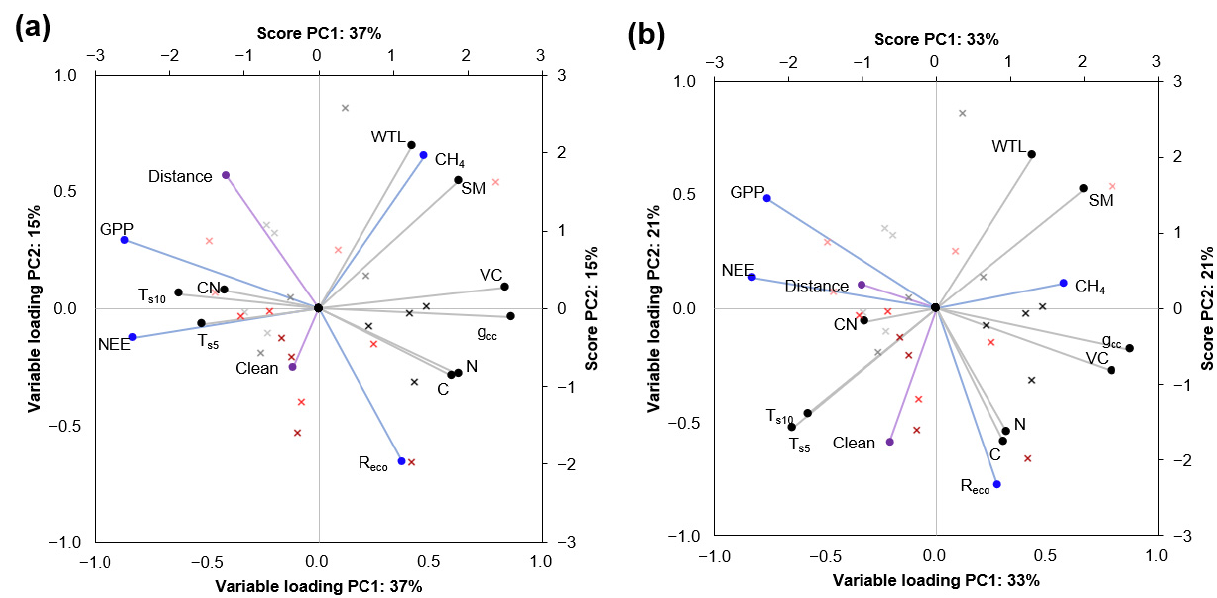
Figure 7. Principal component analysis (PCA) biplots of the first two principal components (PC1 and PC2) based on the plot-averaged measurement data displaying variable loadings and object scores, during ( a ) pre-DC and ( b ) post-DC periods. Variable loadings of all other significant PCs are listed in Table S3. Filled symbols denote the component loadings of the measured variables. Crosses highlighted in black (control area) and red (DC area) denote the component scores of each measurement plot. Colour intensity of component scores decreases with the distance to the ditches. Note that ecosystem uptake in NEE and GPP is given a negative sign, resulting in negative correlation to both PC1s despite positive causal relation. Abbreviations represent greenness index ( g cc ), soil moisture (SM), air temperature (T a ), soil 5 or 10 cm depth temperature (T s5 , T s10 ), vegetation areal coverage (VC), water table level (WTL), soil carbon (C) and nitrogen content (N) along with their C:N ratio (CN) for environmental variables (black symbols); net ecosystem exchange (NEE), ecosystem respiration ( R eco ), gross primary productivity (GPP) and methane (CH 4 ) for flux variables (blue symbols); and DC treatment and distance to ditch variable (purple symbols). Note that the DC variable was fitted as a binary variable for control (0) and DC (1)